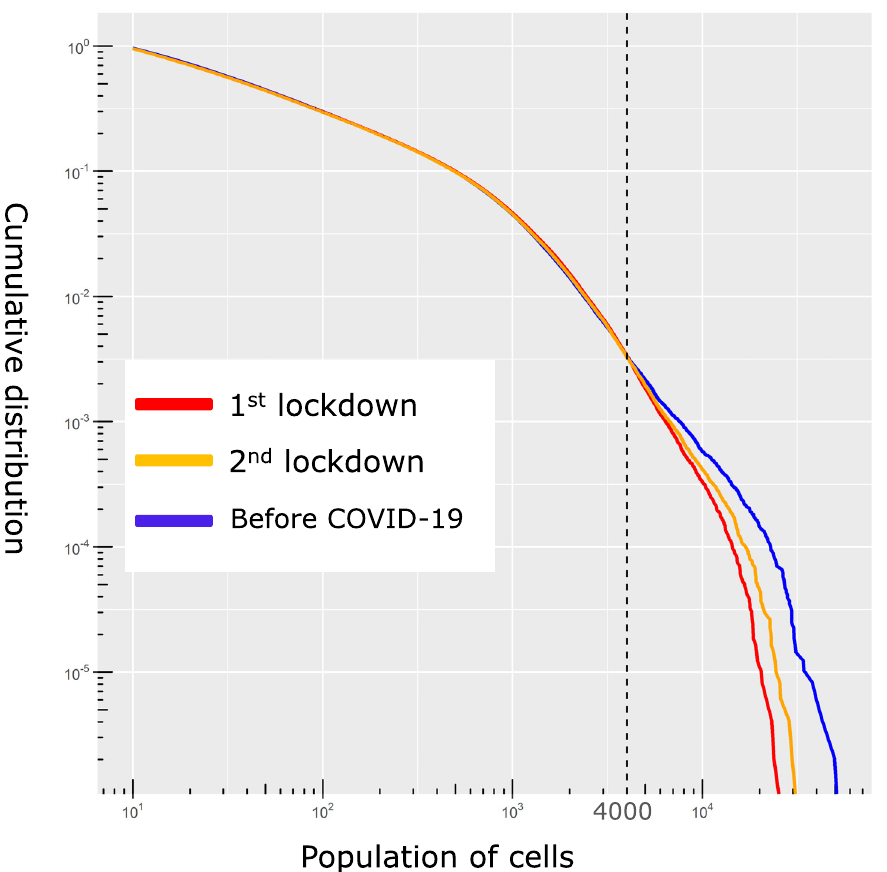
Fig 4. Complementary cumulative distribution function of population in approximately 500m × 500m grid